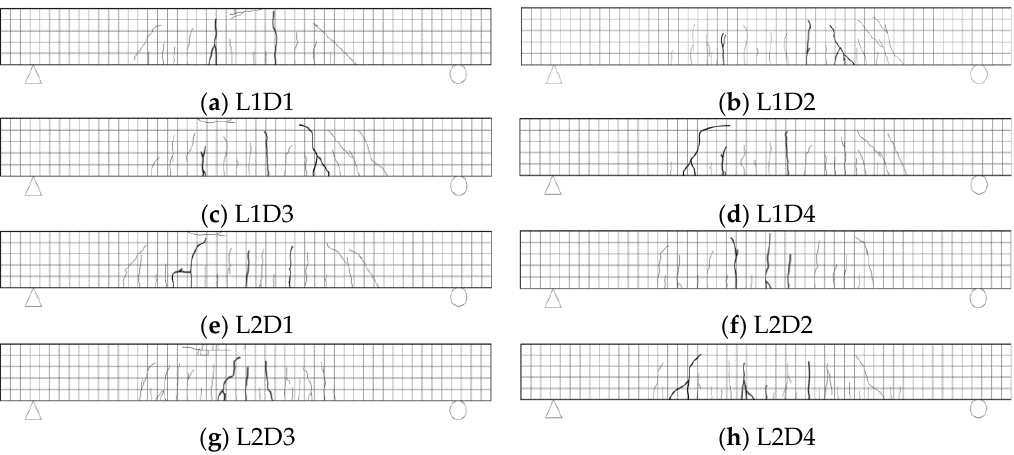
Figure 10. Distribution of cracks in ceramsite concrete beams.